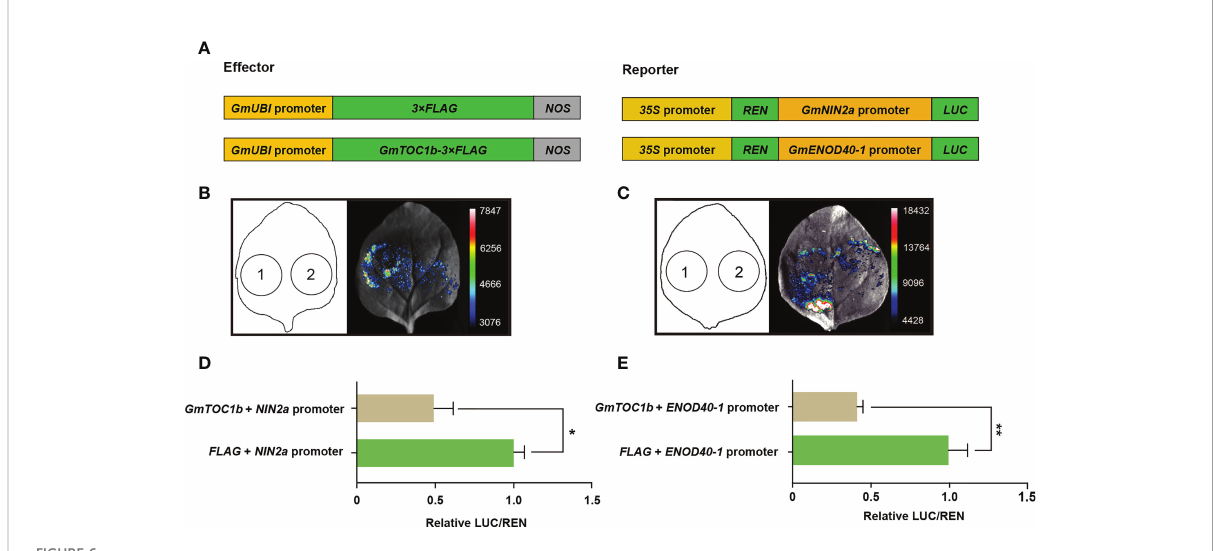
FIGURE 6 GmTOC1b represses the transcription of GmNIN2a and GmENOD40-1 . (A) Schematic diagram of the constructs used for the transient co- transfection assay. (B) Representative image of fi re fl y luciferase (LUC) activity driven by the GmNIN2a promoter. 1, proGmUBI:3×Flag + proGmNIN2a:LUC ; 2, proGmUBI : GmTOC1b-3×Flag + proGmNIN2a:LUC . (C) Representative image of luciferase activity driven by the GmENOD40-1 promoter. 1, proGmUBI:3×Flag + proGmENOD40-1:LUC ; 2, proGmUBI : GmTOC1b-3×Flag + proGmENOD40-1:LUC . (D, E) GmTOC1b represses GmNIN2a and GmENOD40-1 promoter activities. Relative fi re fl y luciferase activity driven by the GmNIN2a (D) or GmENOD40-1 (E) promoter was normalized to CaMV 35S promoter-driven Renilla luciferase (REN) activity. Data are means ± SD of seven independent samples (* p < 0.05; ** p <